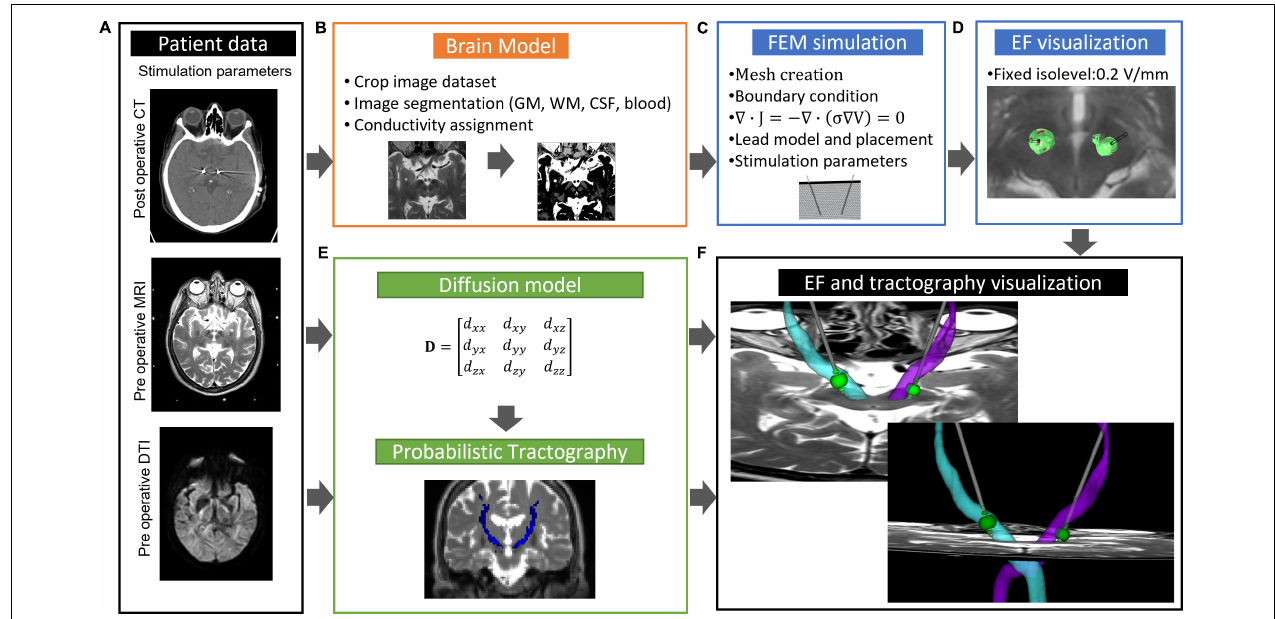
FIGURE 6 | Overview of workflow for patient-specific EF simulation and tractography. (A) MRI and stimulation parameters; (B) creation of brain model; (C) set up of FEM simulation; (D) visualization of electric field superimposed on preoperative MRI; (E) diffusion model for probabilistic tractography; and (F) visualization of electric field, tractography superimposed on preoperative MRI. GW, gray matter; WM, white matter; CSF, cerebral spinal